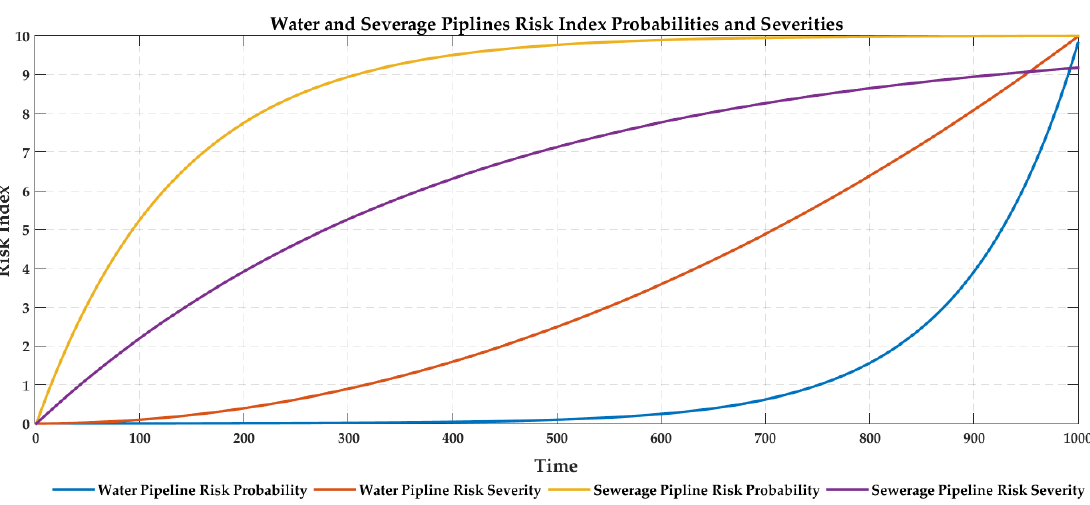
Figure 16. Data generated through different functions for water pipeline and sewerage pipeline risk probabilities and severities.